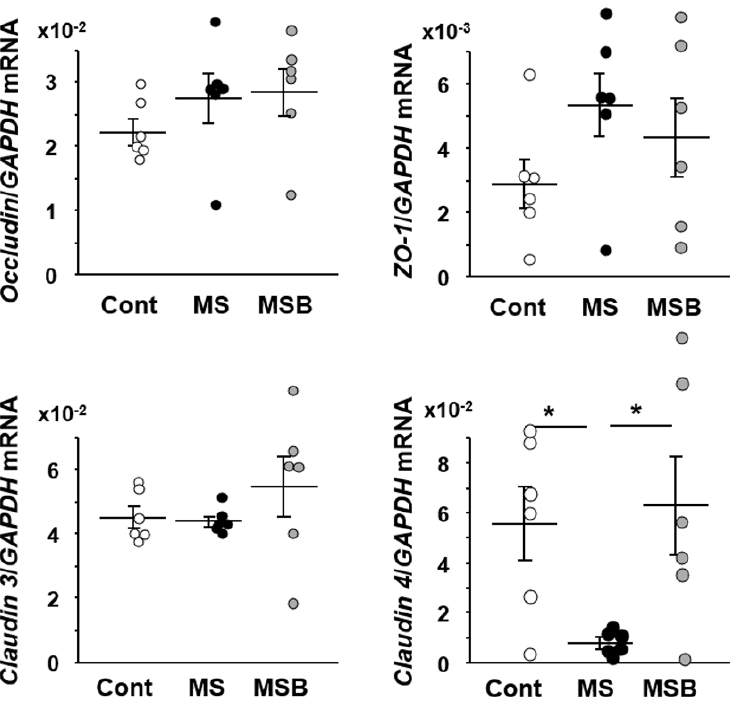
Figure 2. Effect of probiotic BBG9-1 on the mRNA expression of tight junction molecules in the colon of MS rats. Results are expressed as mean ± SEM. Cont, control ( n = 6); MS, maternal separation ( n = 6); MSB, MS with BBG9-1 treatment ( n = 6). Significant differences between two groups at * p < 0.05.